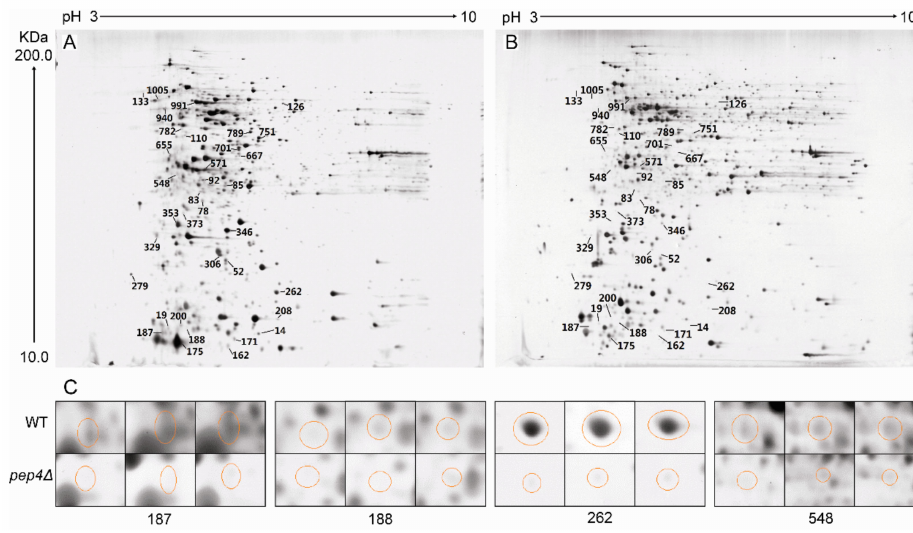
Figure 2. 2-DE gel maps of intracellular proteins from BY4741 (WT) and pep4 ∆ strain. ( A ) wild-type strain BY4741. ( B ) Pep4p-deficient yeast strain (pep4 ∆ ). ( C ) Ssa1 (Spot 187), Fba1p (Spot 188), Eno2p (Spot 262), and Pdc1p (Spot 548) from three independent 2-DE gel maps were compared, and highlighted with